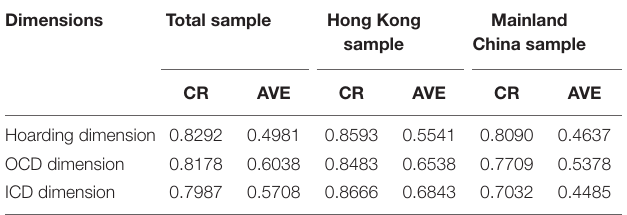
TABLE 4 | Average variance extracted and composite reliability of samples of Total, Hong Kong, and Mainland China within hoarding, OCD and ICD